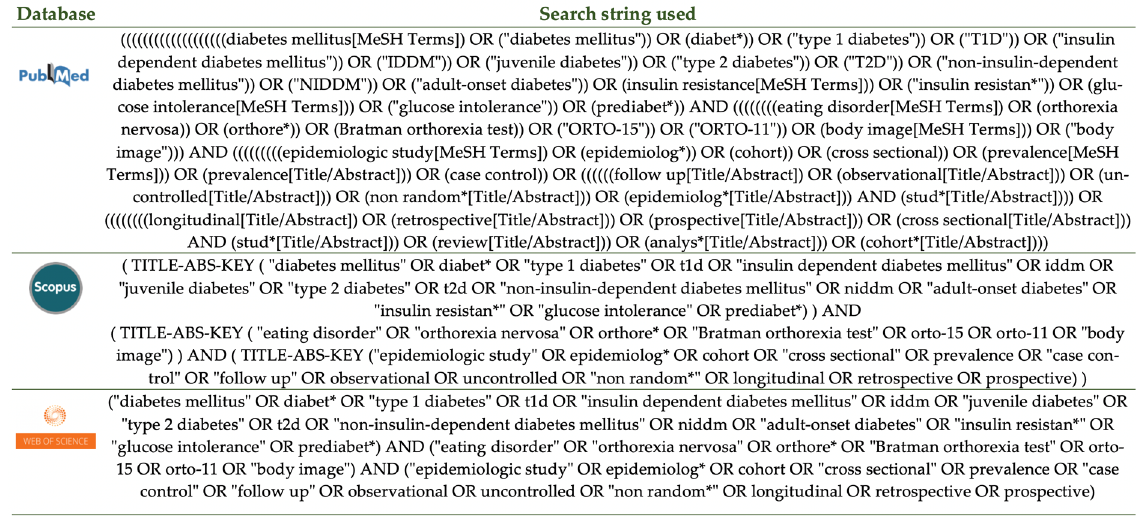
Figure 1. The search strategy applied in the three databases.